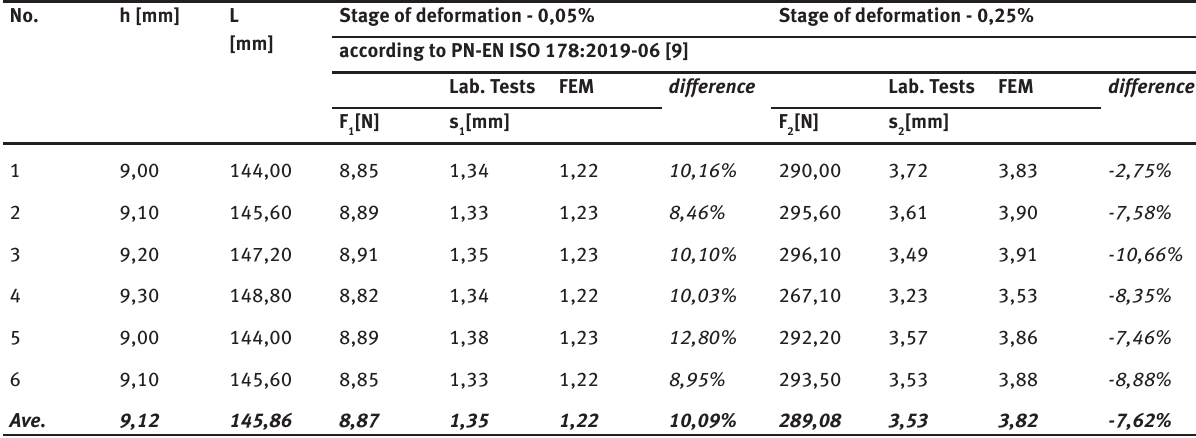
Table 10: Comparison of results of numerical analyses and laboratory tests for a model of a liner with a diameter of 500mm and 9,00mm wall thickness.